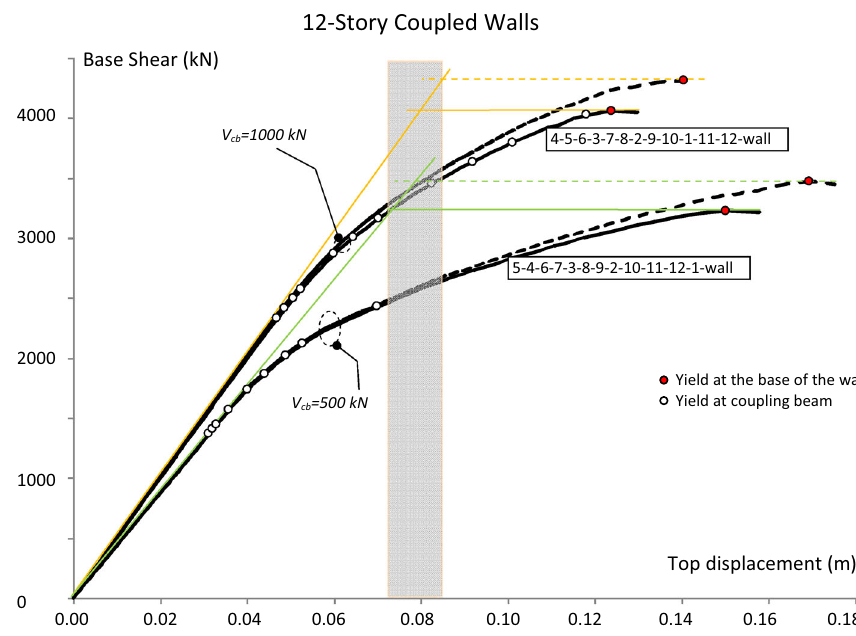
Fig. 7 Capacity curves for the set of 12-story coupled